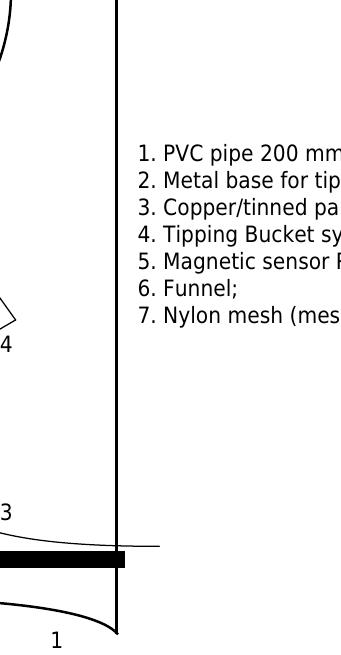
Figure 3. Vertical cross-section of the automatic runoff-measuring